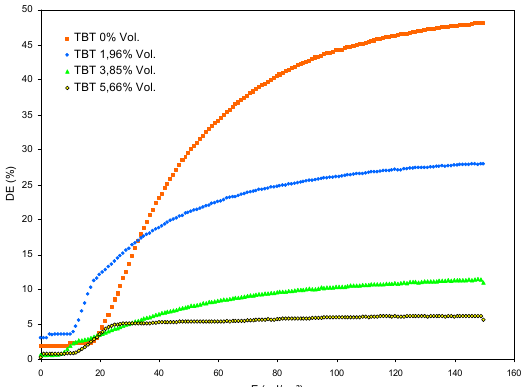
Figure 8. Diffraction efficiency versus energetic exposure for samples with polymer B and different concentrations of TBT.